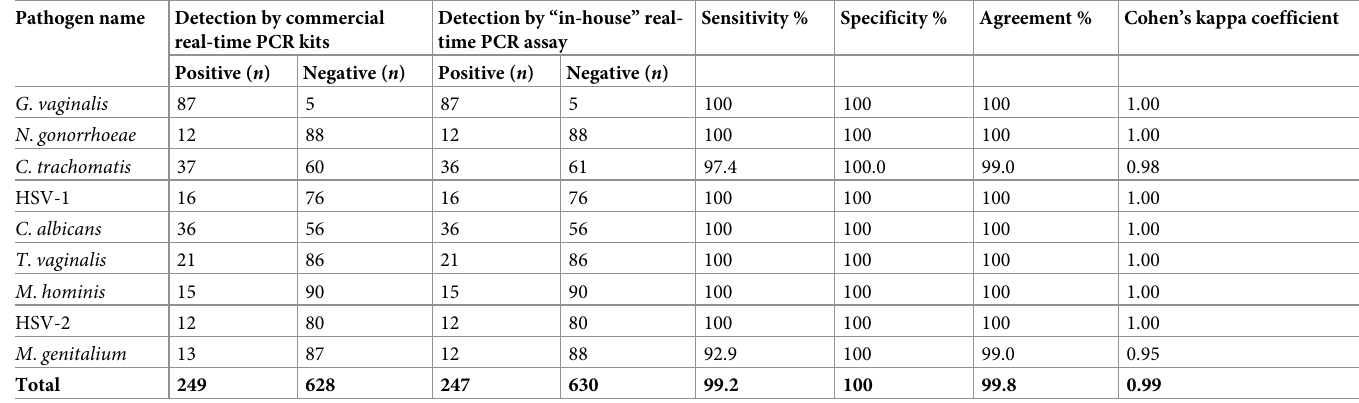
Table 3. Performance of “in-house” multiplex real-time PCR assay for STI identification compared to real-time PCR commercial kits used in hospitals. Pathogen